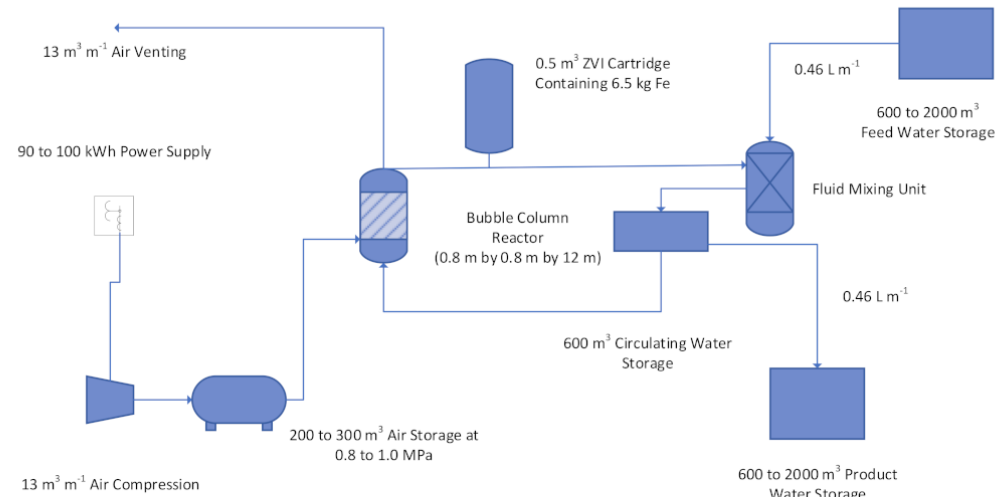
Figure 15. Expected structure of a reactor unit processing, continuously, 660 m 3 d − 1